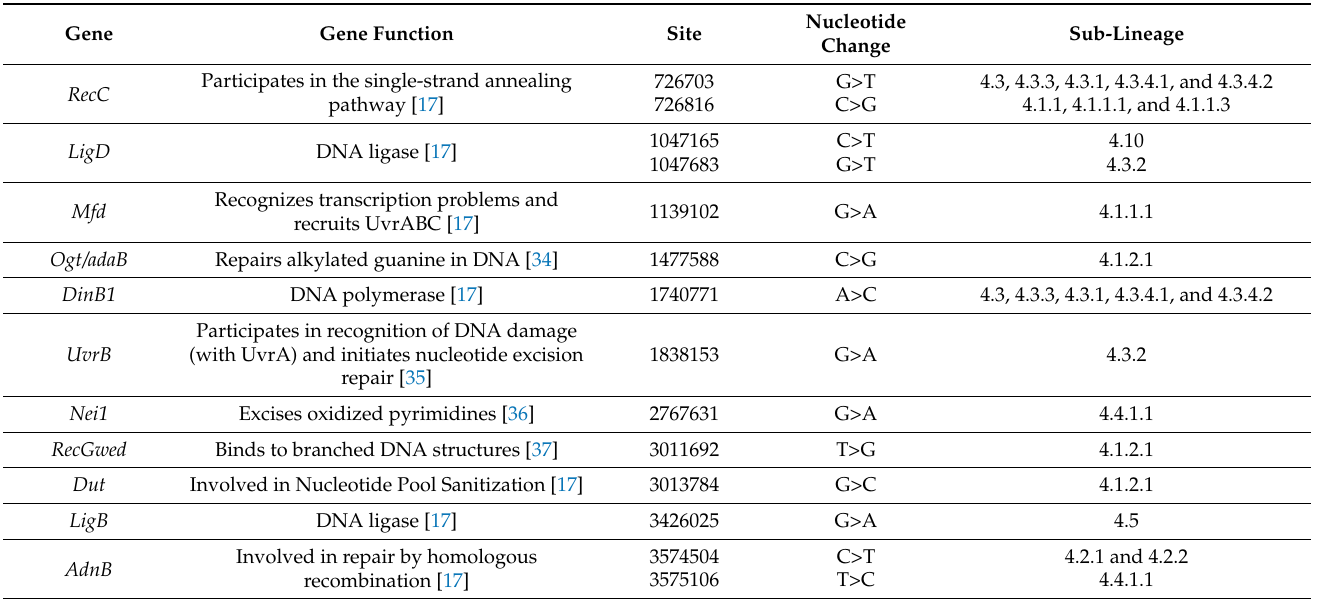
Table 2. Nonsynonymous SNPs in DNA damage repair-related genes used to classify